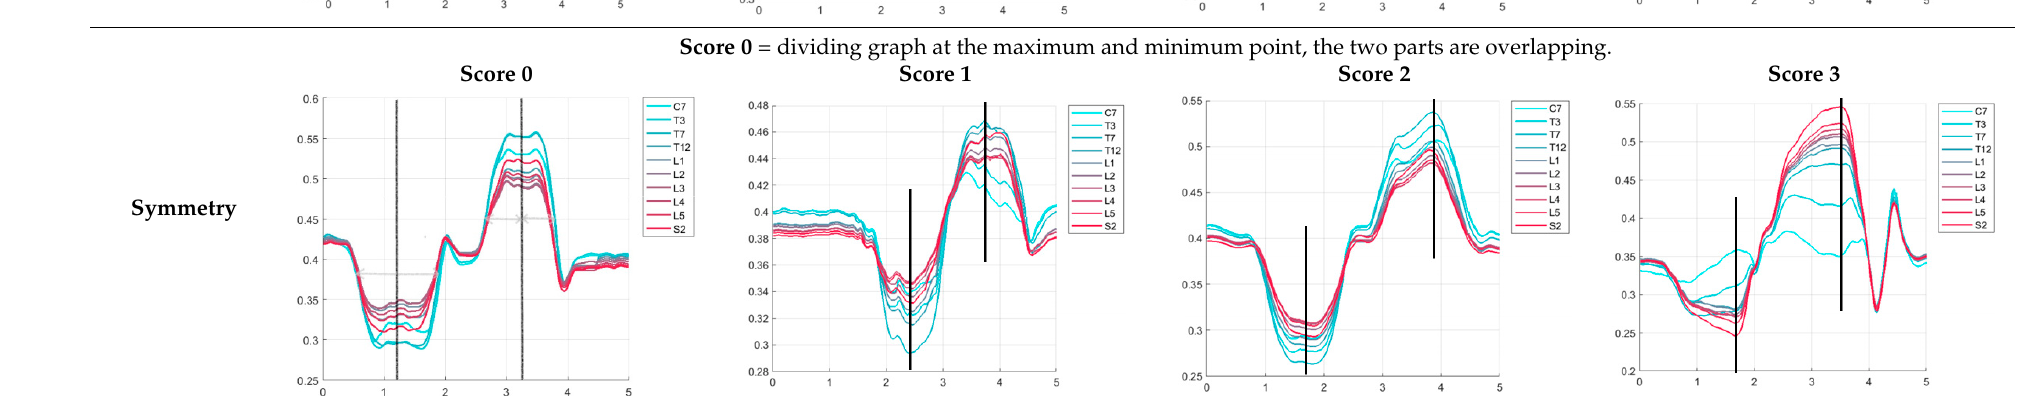
Score 0 = at the end of the movement, the S2 line arrives at the same level as the start. End Score 0 Score 1 Score 2 Score 3